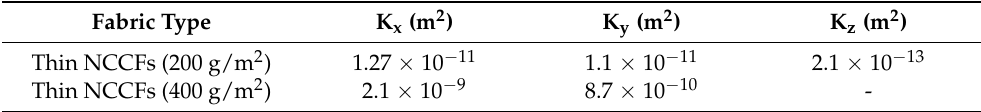
Table 1. Permeability values for thick and thin NCCFs.